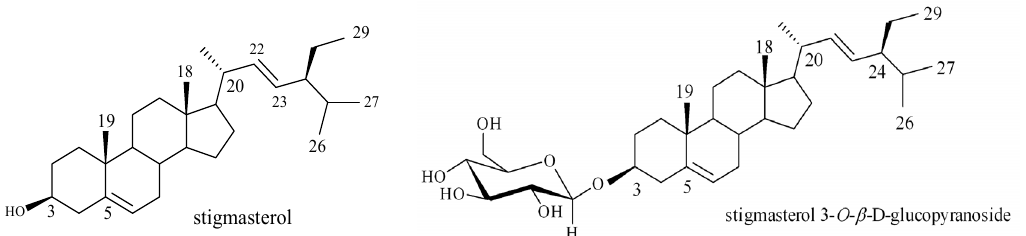
Figure 1. Structures of the isolated compounds from Terminalia mantaly (Combretaceae). The isolated compounds were tested against pathogenic yeast isolates and enzymes of metabolic significance. 3,3 ′‐ di ‐ O ‐ methylellagic acid 4 ′‐ O ‐α‐ rhamnopyranoside: IC 50 = 39 μ g/mL C. parapsilosis ; 9.7 μ g/mL C.